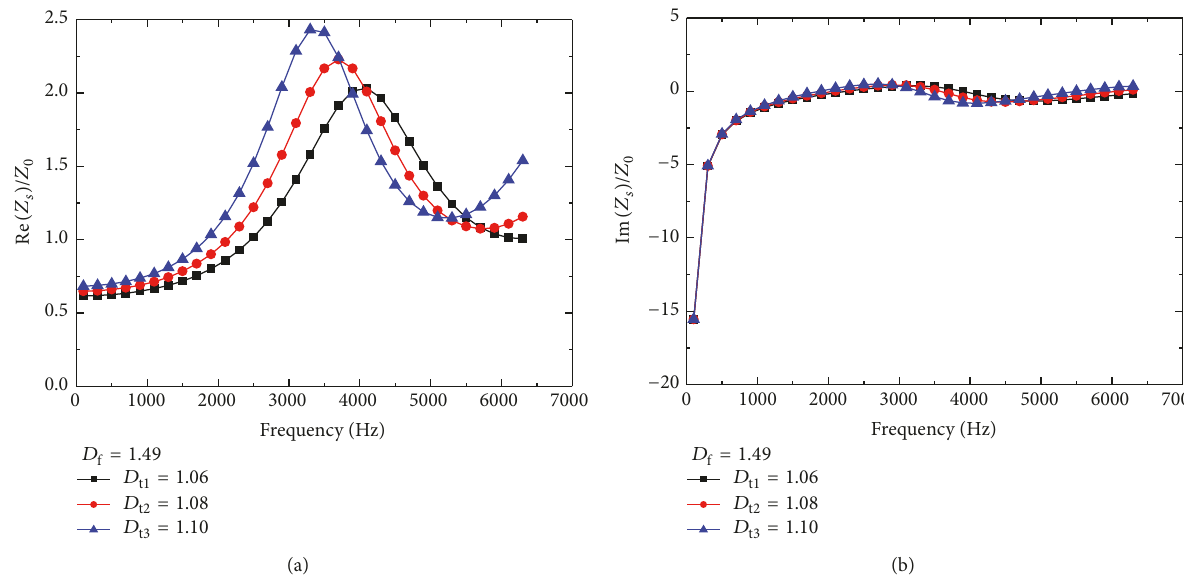
Figure 15: Predictions of specific surface acoustic impedance 𝑍 s / 𝑍 0 with different tortuosity fractal dimensions. (a) The real part of 𝑍 s / 𝑍 0 . (b) The imaginary part of 𝑍 s / 𝑍 0 .